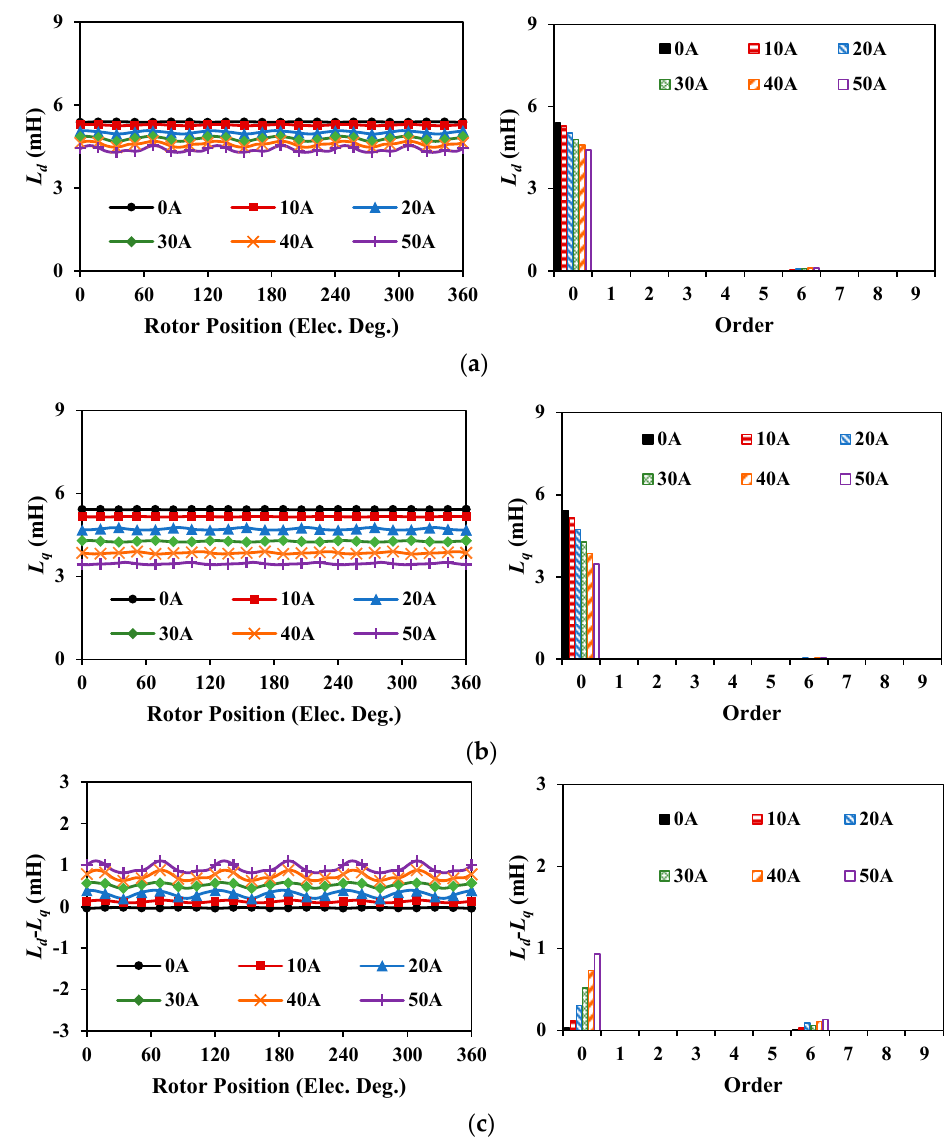
Figure 18. Inductances and spectra for 12s10p SPM machine. ( a ) L d . ( b ) L q . ( c ) L d - L q .